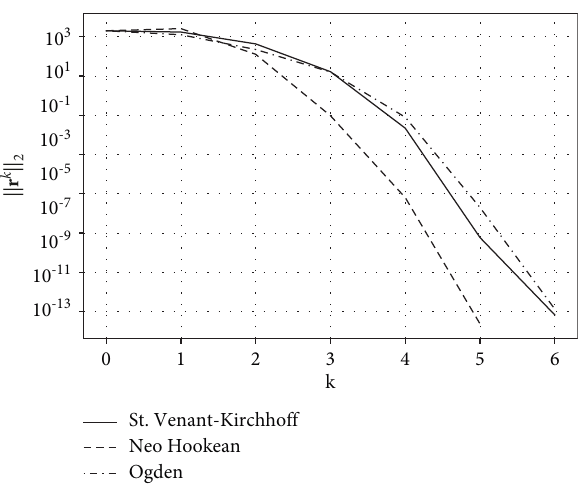
Figure 22: Convergence of the 2D nonlinear truss structure for diferent hyperelastic material laws.